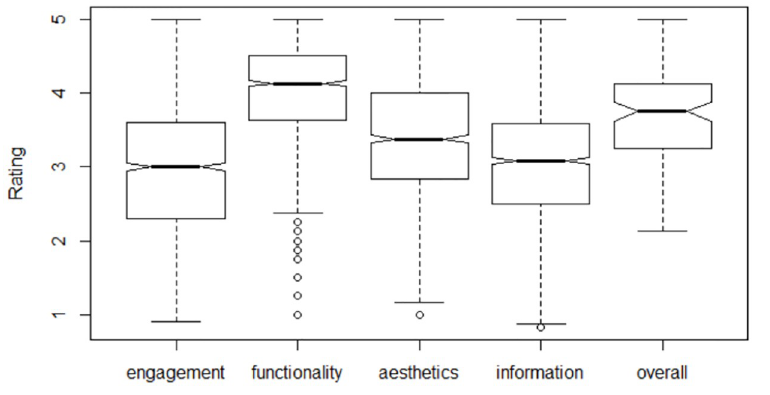
Fig 5. Quality of included MHA.